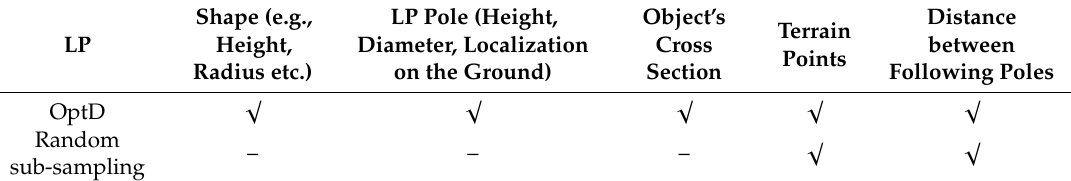
Table 9. Information about LP preserved after data reduction.